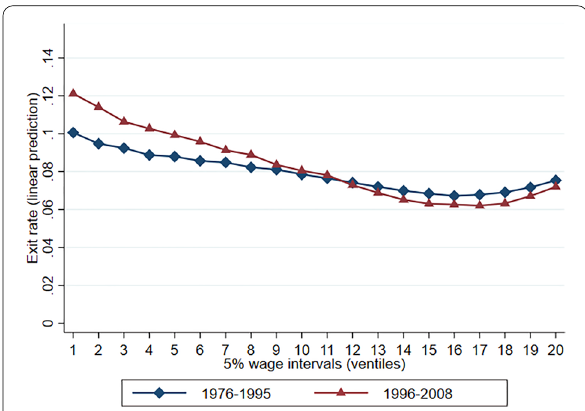
Fig. 8 Exit rates dependent on the wage level for different birth cohorts. The underlying model includes every establishment that has been recognized as an entry, and that can be assigned a specific entry year and age. Confidence intervals are omitted here as they are very